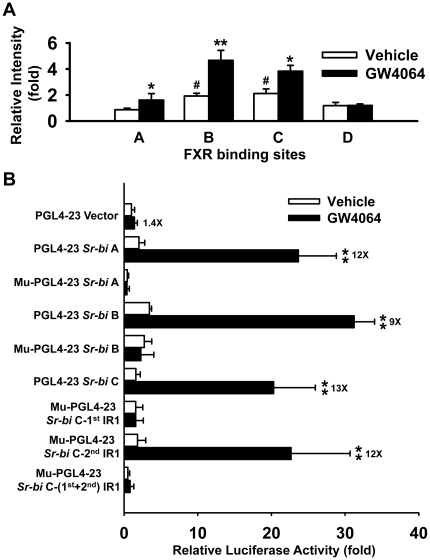
FXR activates Sr-bi by binding to the IR1s within the first intron, but not the downstream region of the Sr-bi gene.
A, ChIP-qPCR assays showed binding of FXR to the intron (binding sites A, B, and C) but not the downstream region (binding sites D) of Sr-bi gene containing the novel IR1s in mouse liver after treatment with GW4064. The relative intensity (fold) indicates fold increase over vehicle treatment. n = 5 mice per group. A pound sign indicates P<0.05 between binding site A and other binding sites. An asterisk means P<0.05 and double asterisks mean P<0.01 between vehicle and GW4064 treatment. B, Luciferase assay revealed that, upon FXR activation, the IR1s at the first intron of Sr-bi gene are functional in enhancing gene transcription. The DNA constructs containing the novel FXR binding sites (IR1s) found in the first intron of Sr-bi gene and the DNA constructs containing mutant corresponding novel IR1s were cloned into a pGL4-23 firefly luciferase vector and transfected into HepG2 cells as indicated in the Methods. The cells were then treated with vehicle (0.1% DMSO) or 1 µM GW4064 for 36 hrs followed by evaluation of luciferase activity. The white bar is for cells treated with vehicle and the black bar is for cells treated with 1 µM GW4064. The relative luciferase activity (fold) indicates fold increase over empty vector by vehicle treatment. The fold induction of luciferase activity by these constructs with GW4064 treatment compared to DMSO is indicated next to the black bars. Double asterisks indicate P<0.01 between vehicle and GW4064 treatment.